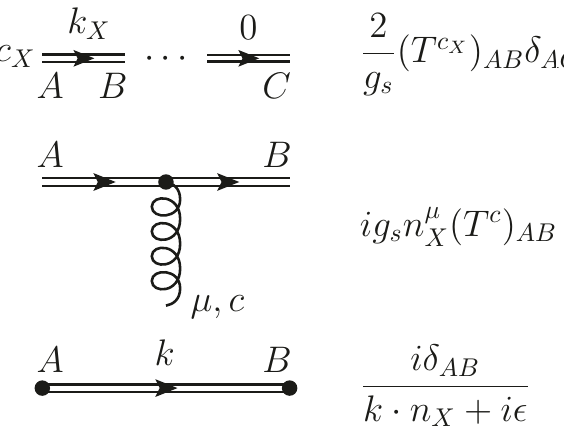
Figure 4 . Feynman rules for the insertion of a Wilson line operator corresponding to an incoming (cid:22) o(cid:11)-shell gluon with colour c , carrying momentum k (cid:22) = z + k (cid:22) . The top-most diagram is X X n X X X; T the so-called skeleton of the Wilson line; the dots denote potential gluon attachments according to the middle diagram, which represents the Wilson line-gluon coupling. The bottom diagram represents the Wilson line